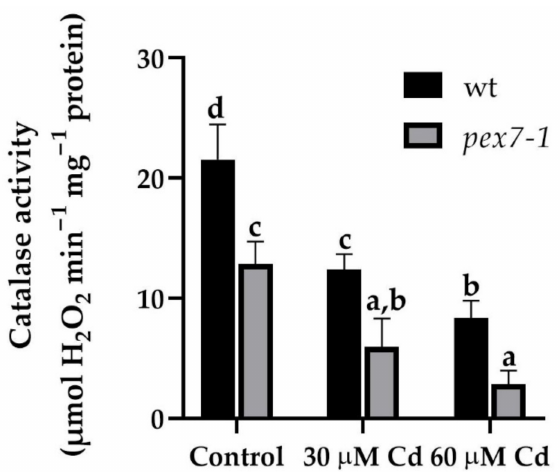
Figure 10. Catalase (CAT) activity, expressed as µ mol H 2 O 2 min − 1 mg − 1 protein in the root system of wt and pex7-1 seedlings grown in the absence (Control) or in the presence of 30 µ M CdSO 4 (30 µ M Cd) or 60 µ M CdSO 4 (60 µ M Cd). Columns labelled with different letters show statistical differences for at least p < 0.05 among treatments within the same genotype and between genotypes within the same treatment. Columns labelled with the same letter are not statistically different ( p > 0.05). Data are means ( ± SE) of three technical replicates from the first biological